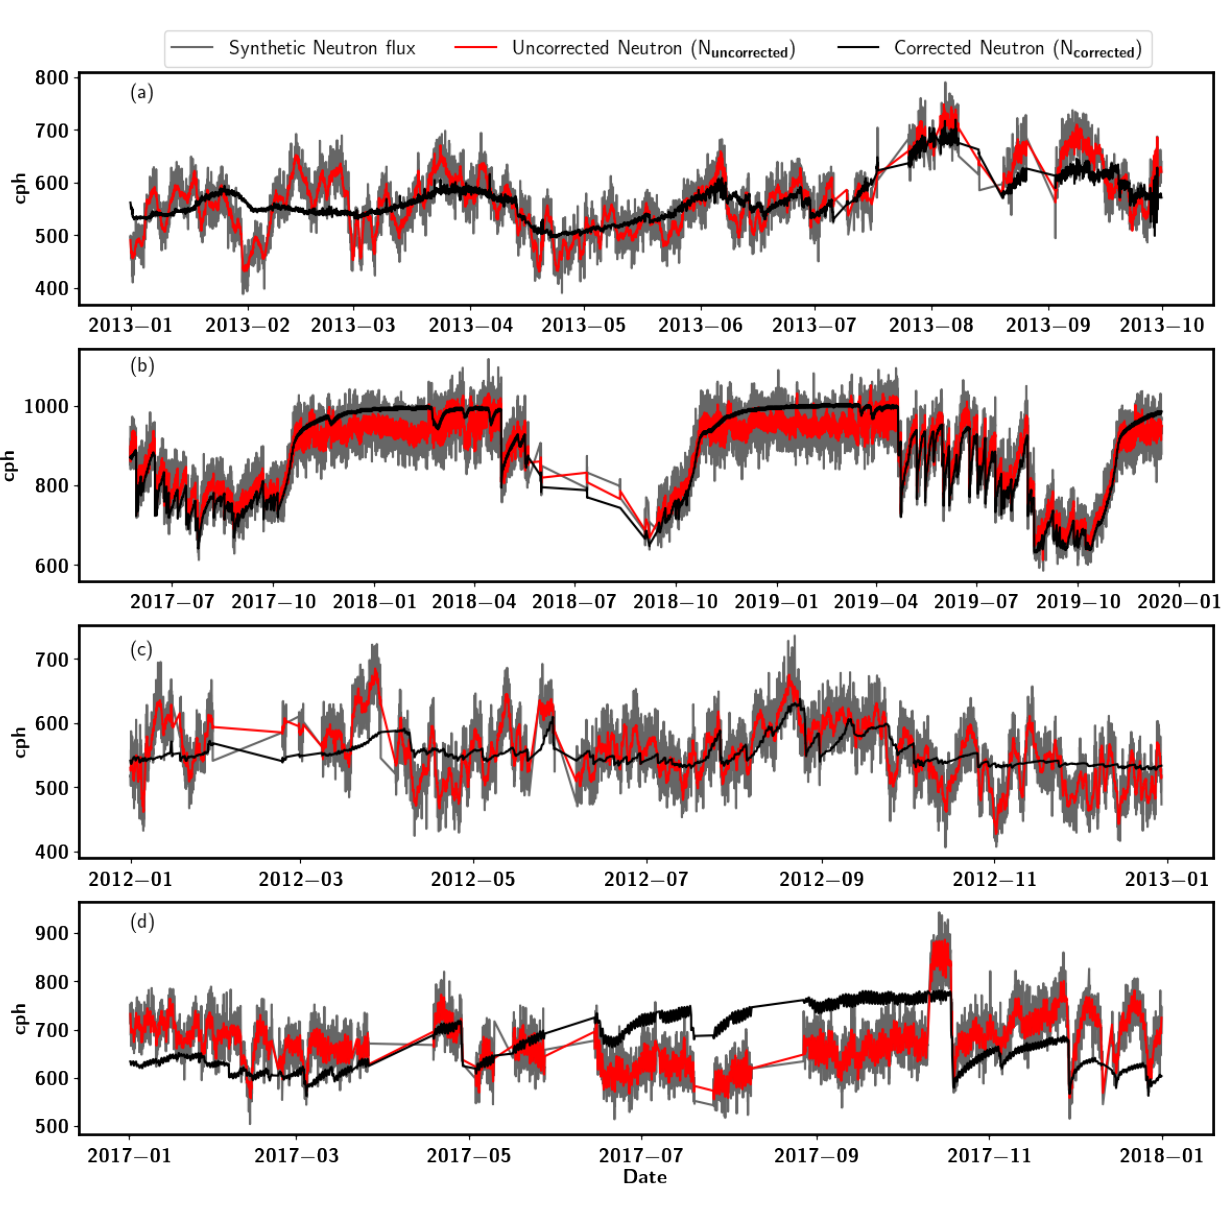
Figure 2. Graphical representation of synthetic neutron flux N syn (gray) generated for Finland ( a ), Gorigo ( b ), Rollesbrioch ( c ) and Conde ( d ). The black line represents the neutron flux N True only subject to the soil moisture change, while red is the uncorrected neutron flux N uncorrected subject to atmospheric factors and soil